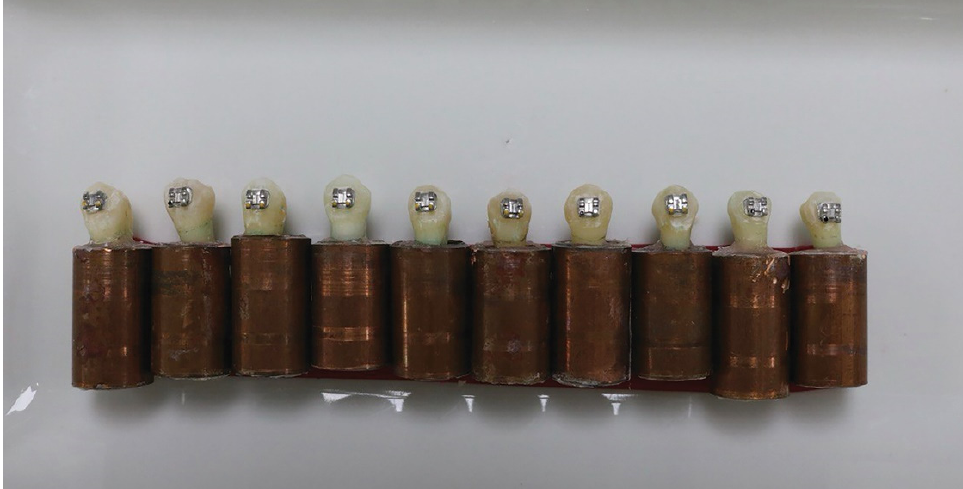
Figure 1. Mounted samples. Table 1. Bracket types and adhesive systems used in the